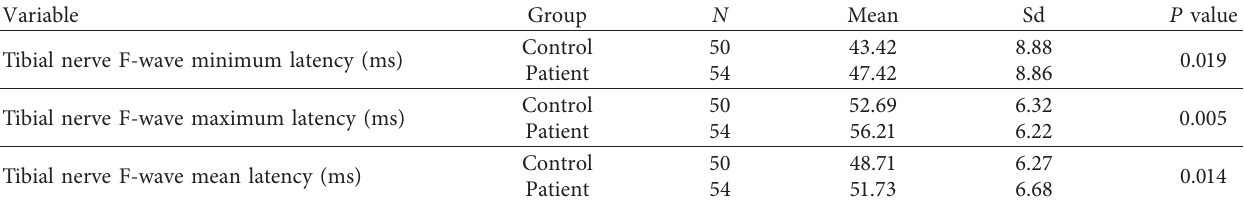
Table 3: F-wave latencies of the tibial nerve (patients group vs control group).